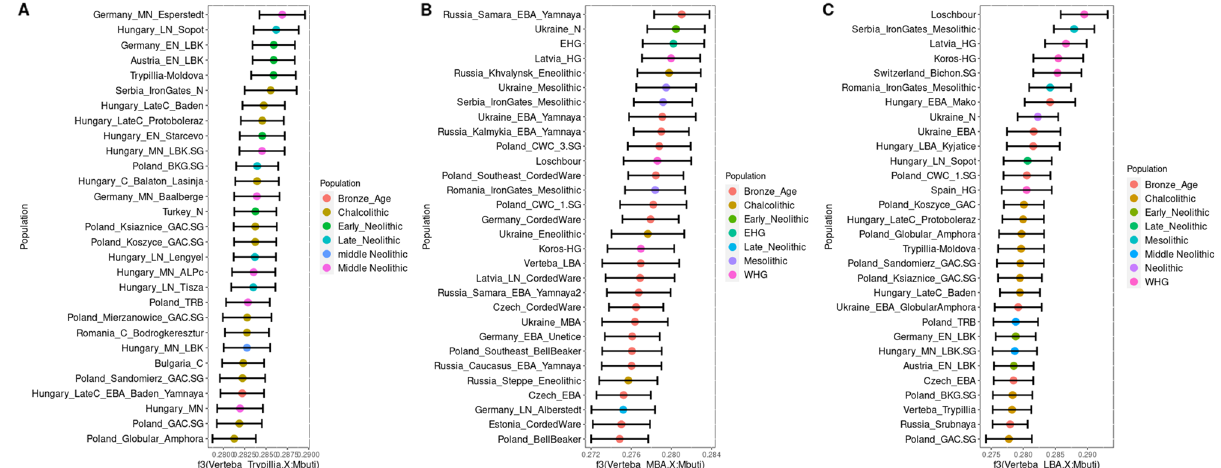
Figure 3. Outgroup- f 3 statistics, the samples have been clustered between: Verteba individuals, individual VERT-114 (Verteba_LBA) and individual VERT-113 (Verteba_MBA). We have plotted the 20 populations with the highest values.